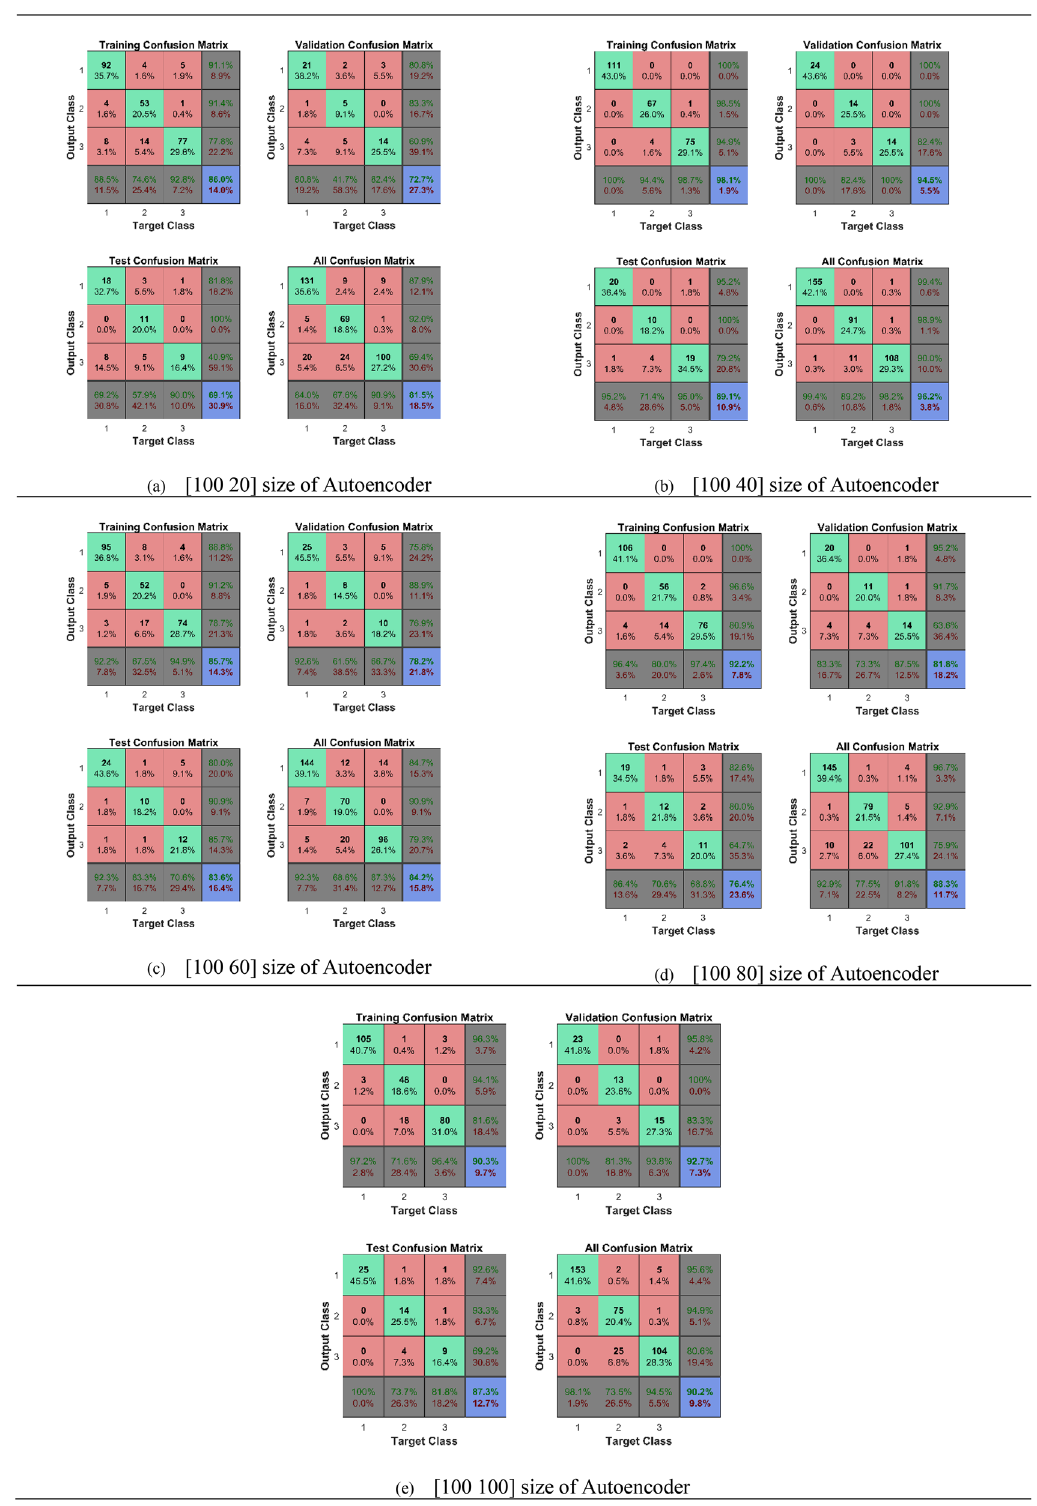
Figure 1. Confusion matrices of proposed deep stacked sparse autoencoder neural network with different number of